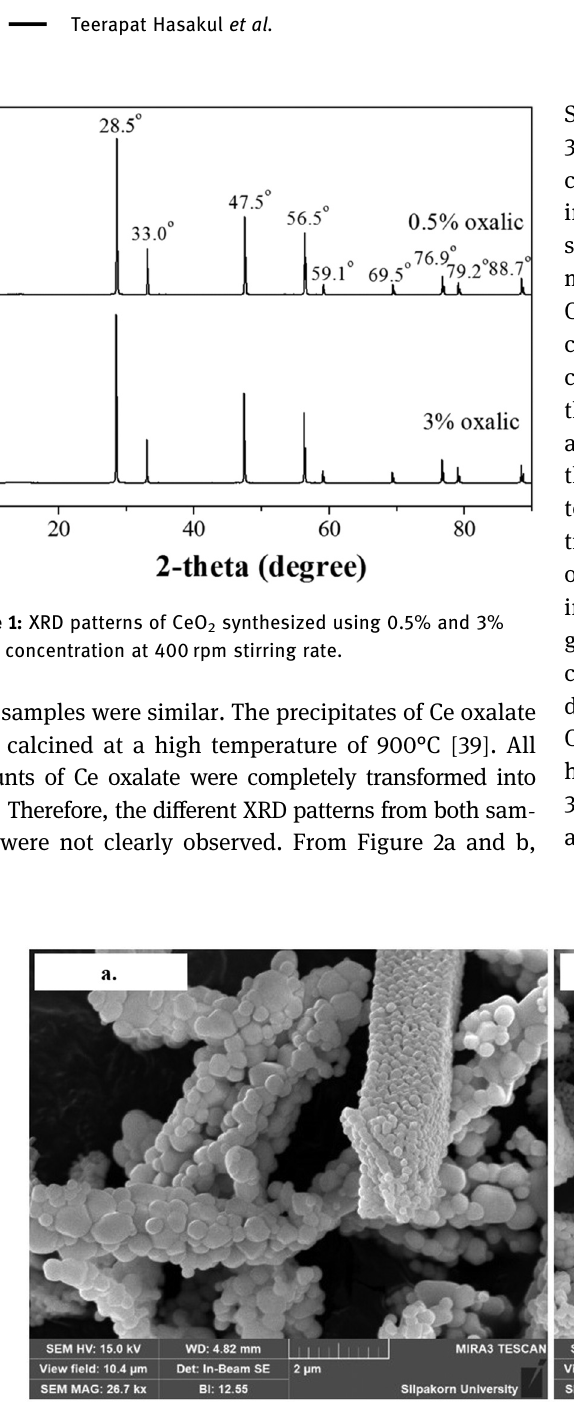
Figure 2: SEM micrograph ( 26,700 × magni fi cation ) of CeO 2 synthesized using di ff erent oxalic concentration: ( a ) 0.5% oxalic and ( b ) 3% oxalic concentration at 400 rpm stirring rate.